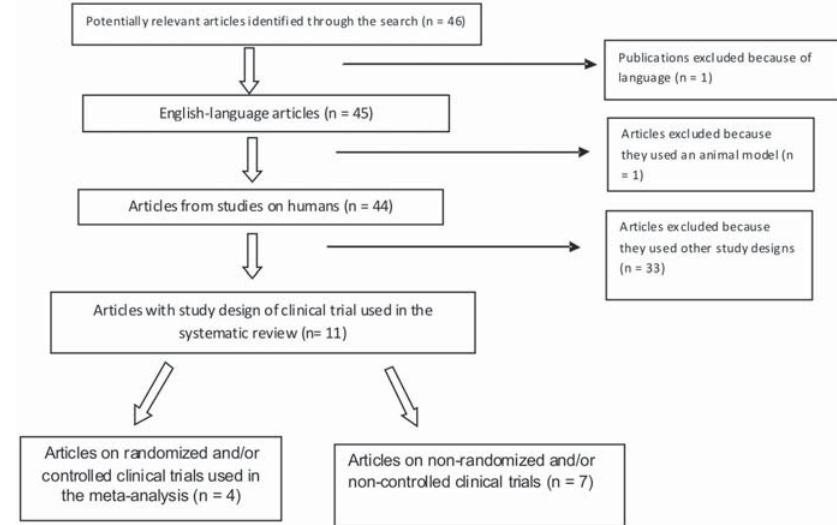
Figure 2- Article selection and inclusion process